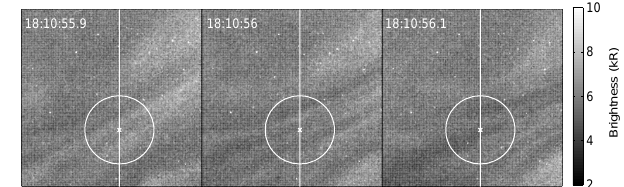
Fig. 2. Sequence of images from ASK1 camera showing filamen- tation in active aurora in nitrogen emission. The circles mark the radar field of view. The lines mark the north-south meridian slice used in Fig. 1.